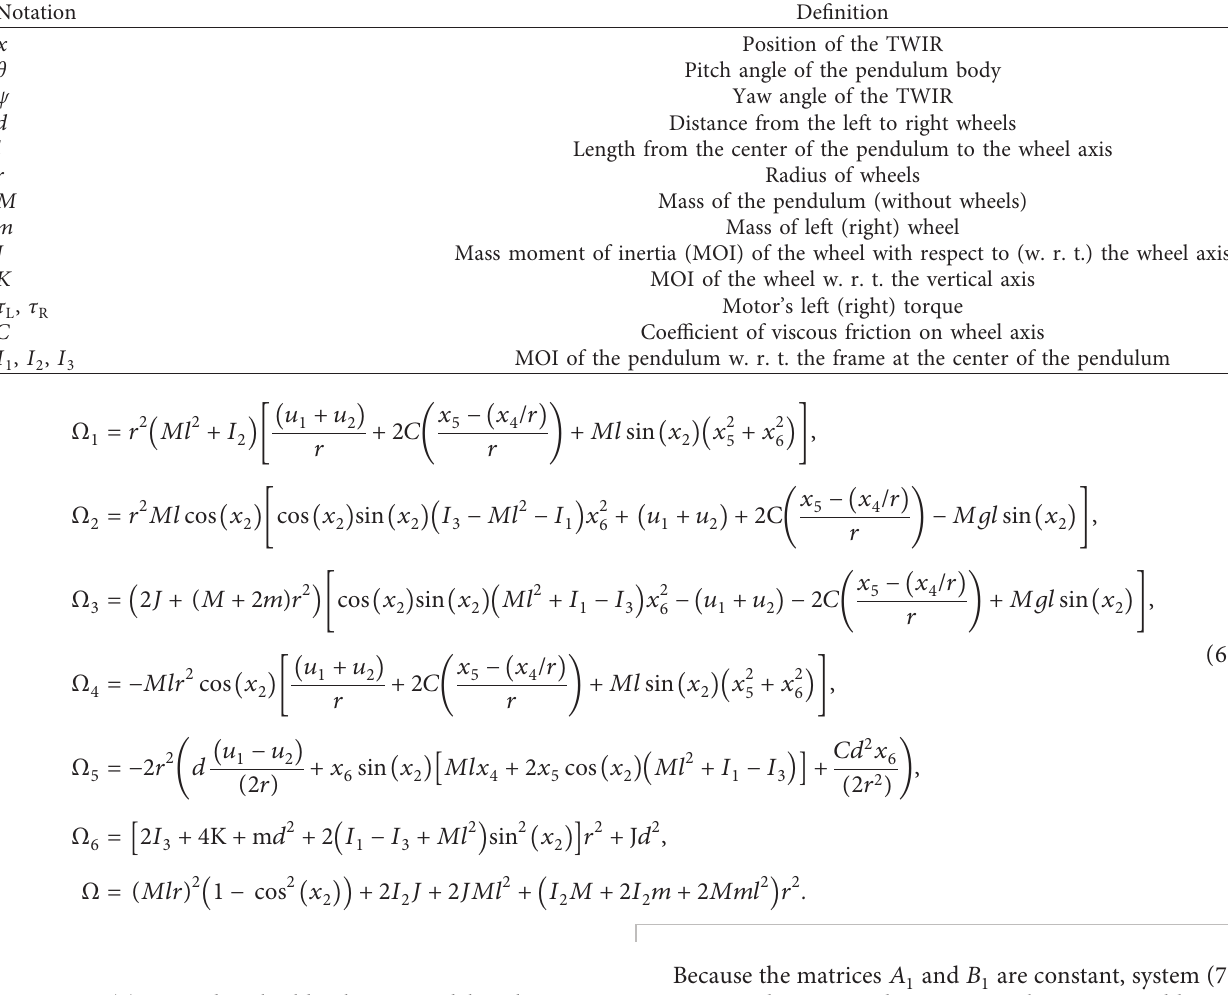
Table 1: TWIP’s notations and